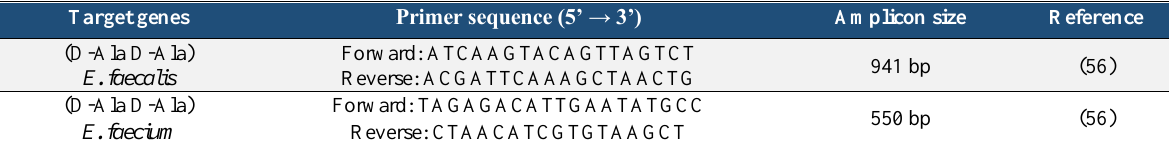
Table 1. The sequence of the primers used in PCR amplification of (D-Ala D-Ala) E. faecalis and (D-Ala D-Ala) E. faecium genes Target